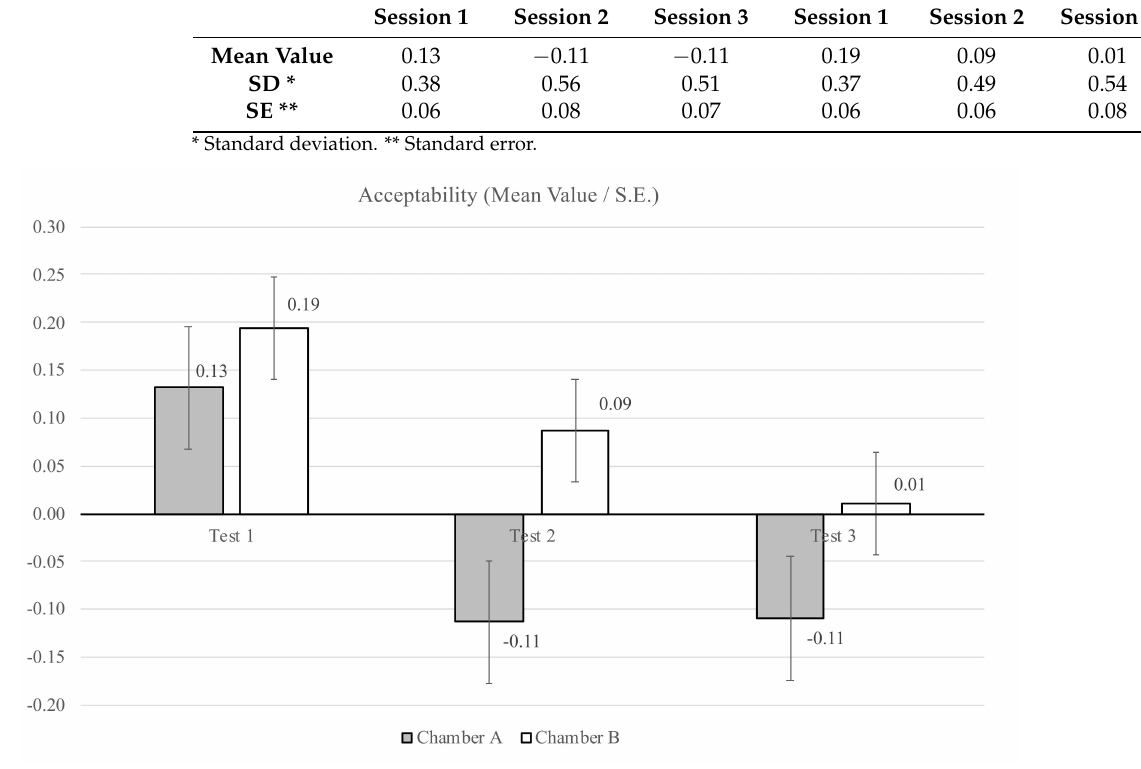
Figure 9. Acceptability assessment for the two chambers during the three sessions: mean values and standard errors (SEs) (Session 1: n = 44; Session 2: n = 57; Session 3: n =